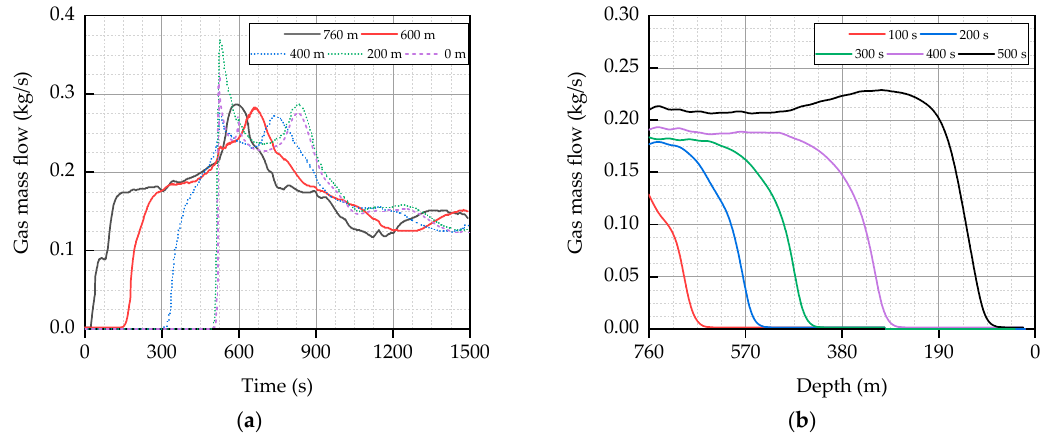
Figure 15. Variation of the gas mass flow at different: ( a ) times; and ( b ) depths.